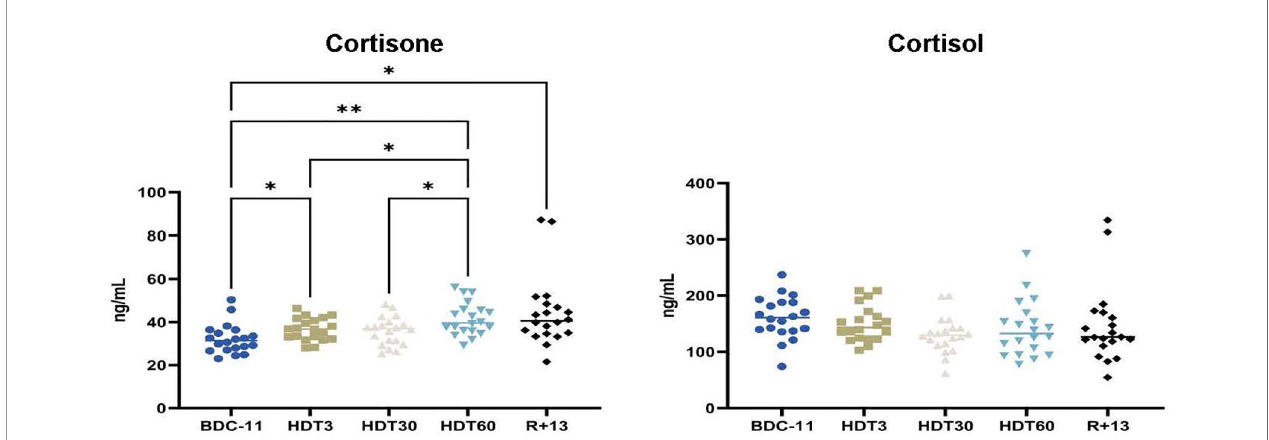
FIGURE 7 | Kinetics of serum cortisone and cortisol levels. As no statistically signi fi cant differences between the control and cocktail groups were observed, individuals of both groups were pooled. n = 20 except for cortisone at R+13 where n = 18. Horizontal bars indicate the median. Statistically signi fi cant differences were found using either one-way ANOVA or a linear mixed effects model analysis. *p < 0.05; **p <